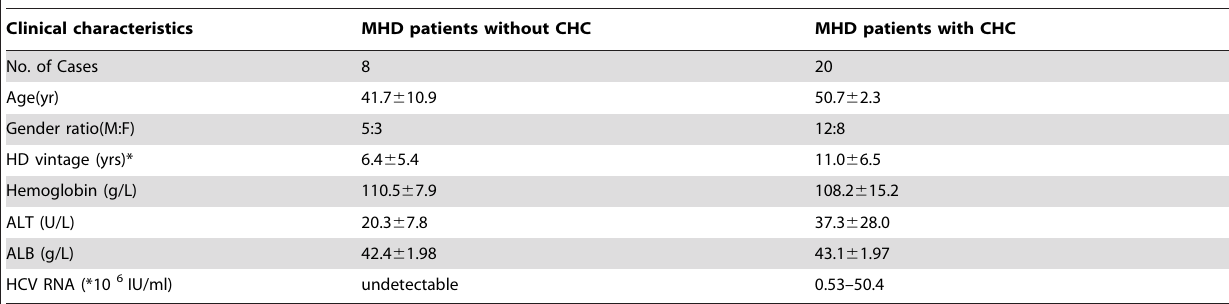
Table 1. The characteristics of MHD patients without and with CHC.